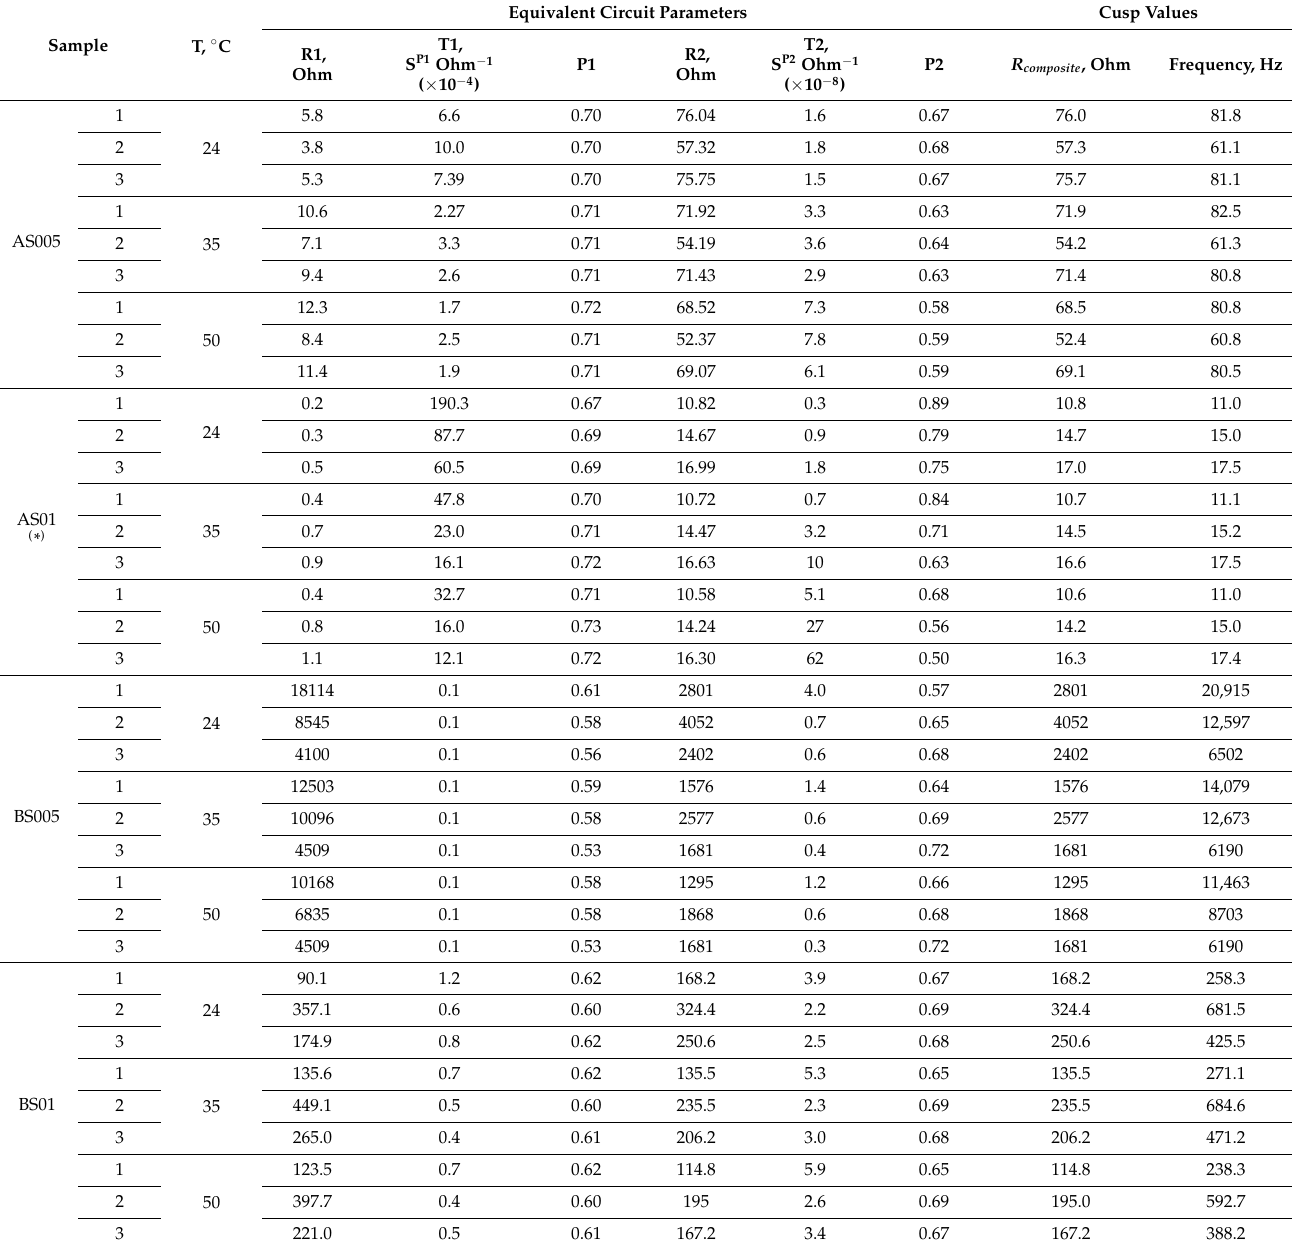
Table 2. Equivalent circuit fitting results and cusp